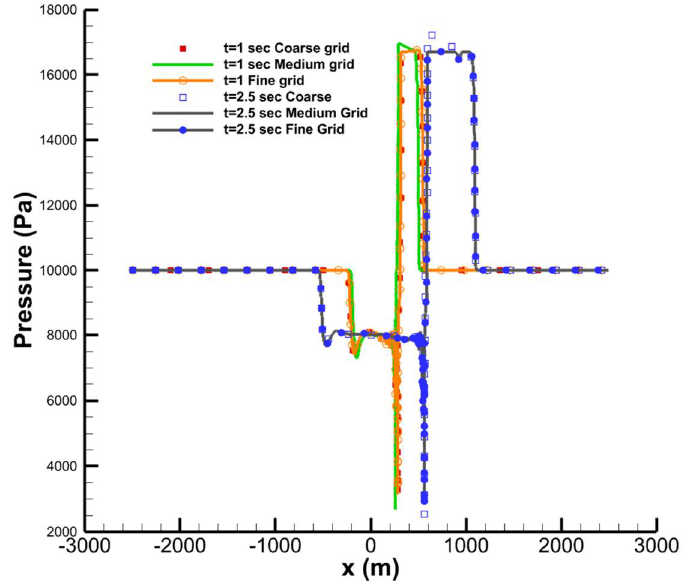
Figure 9. Pressure distribution at y = 2 m (between the tube and the vehicle), t = 1, 2.5 s, with different grids using the k- ε realizable model. The pressure and Mach number contours provided in Figure 10 were obtained with the k-ε turbulent model. The solution represents a compression in front of the vehicle that causes the “piston effect” [52].